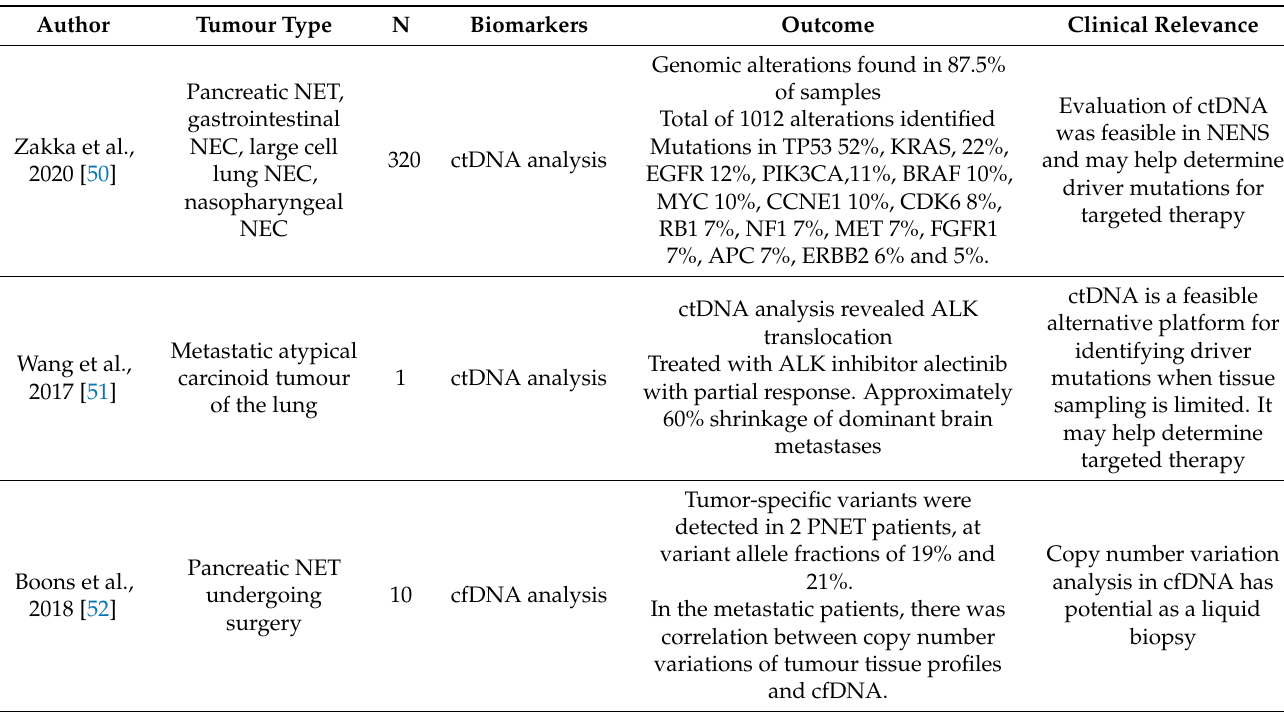
Table 2. Summary of available evidence of potential utility of circulating tumour DNA (ctDNA) in patients with neuroen- docrine neoplasms